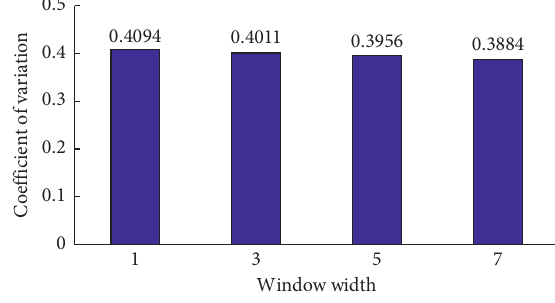
Figure 4: The coefficient of variation test. Table 1: Selection of key impact factors by the proposed combined